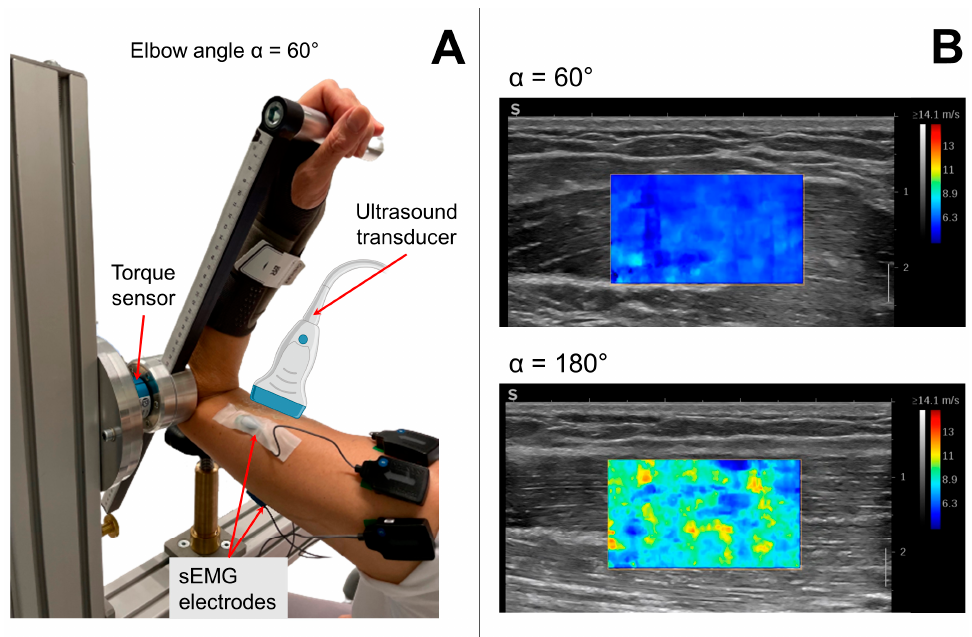
Figure 1. ( A ) Experimental setup showing a patient’s left arm placed in the custom-made apparatus. The elbow joint axis is aligned with the rotational axis of the torque sensor. Surface electromyography (sEMG) electrodes are positioned at the biceps brachii (BB) and triceps brachii muscle. The ultrasound transducer is placed on top of the BB muscle belly and aligned with muscle fiber direction. ( B ) Exemplary ultrasound frames including shear wave propagation speed color overlays during 50% isometric ramp contractions for two elbow angles (60°, 180°) studied.